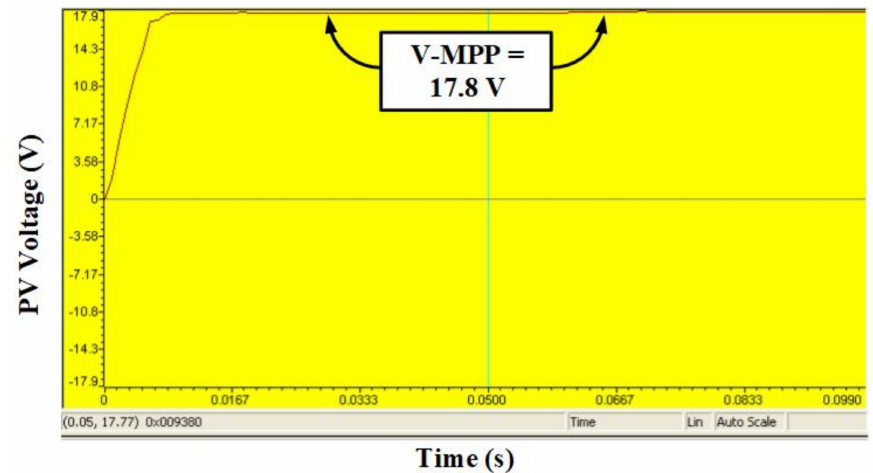
Figure 17. The measured PV voltage of DSM based FLC at normal